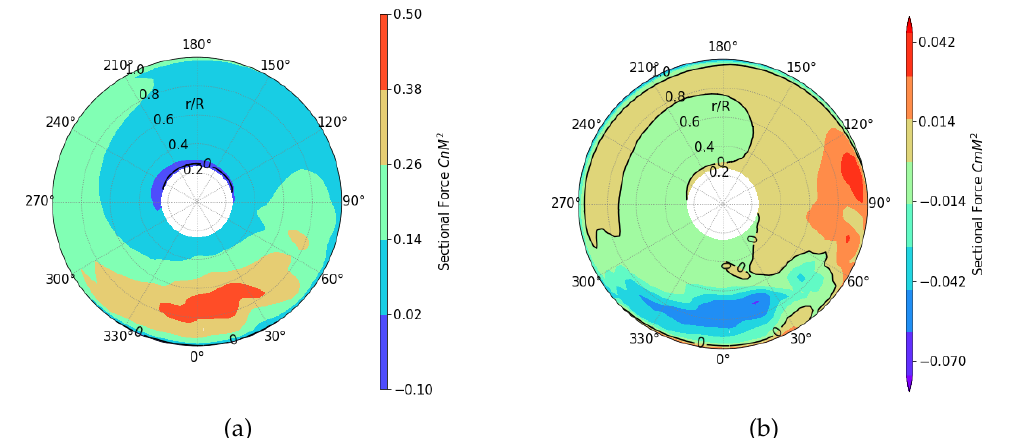
Figure 6. Rotor map of sectional force coefficients. ( a ): CnM 2 sectional normal force coefficient normalised by sonic speed; ( b ): CmM 2 sectional pitch moment